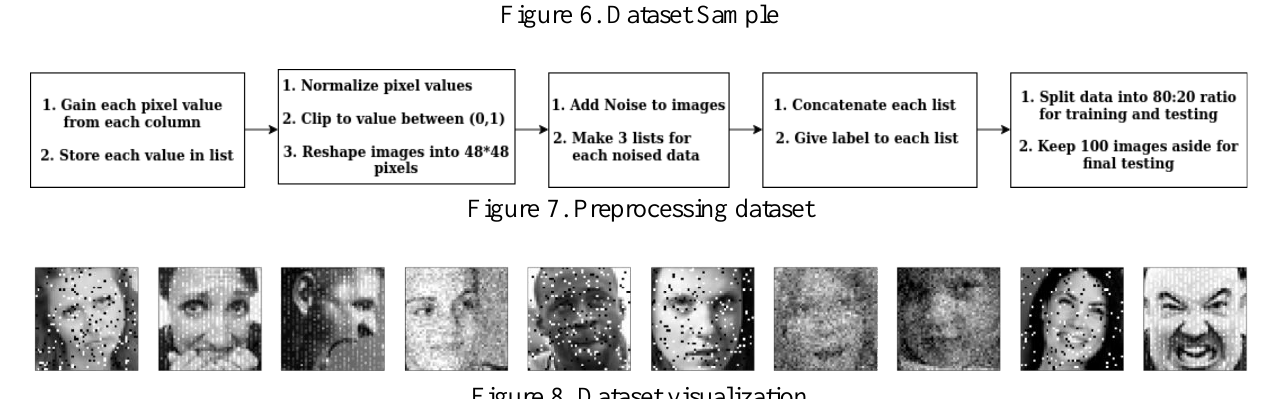
Figure 8. Dataset visualization